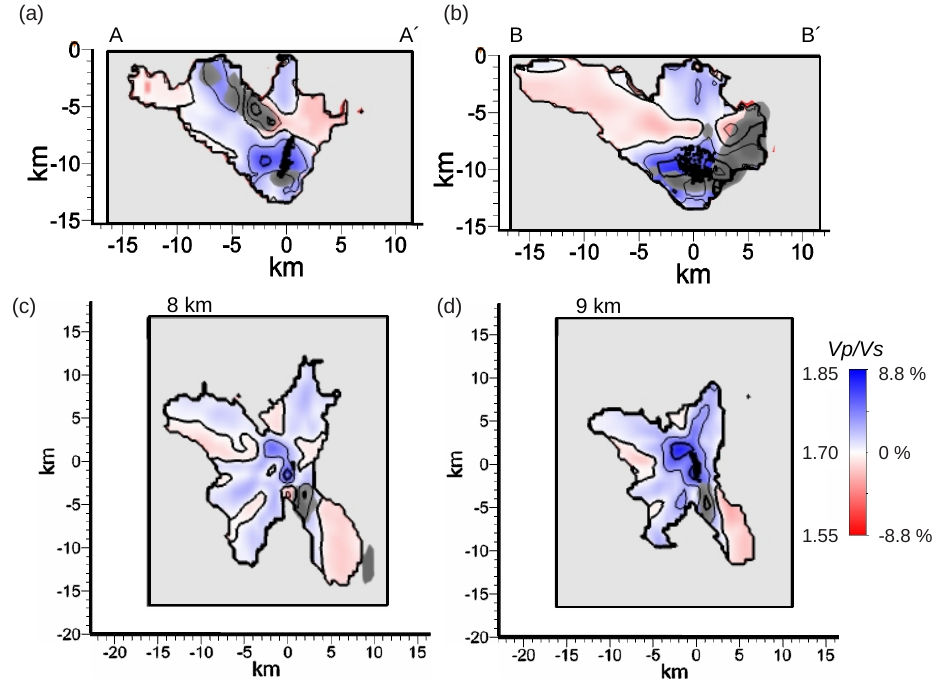
Figure 5. Vp / Vs ratio weighted average model. In the across-strike (a) and along-strike (b) profiles, the focal zone is characterized by high Vp / Vs values. Depth slices through the hypocentres at 8km (c) and 9km (d) show that these higher values concentrate along the fault plane. An almost-continuous layer of low Vp / Vs overlays the hypocentres between 5 and 7km. Grey mask shows areas with WSTD greater than 0.03kms − 1 . Only areas constrained by the data are shown. Earthquake hypocentres are projected onto the profiles and depth slices.